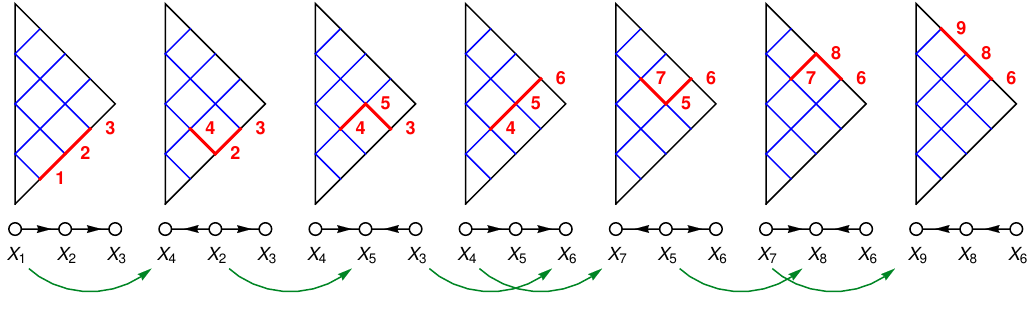
Figure 13 . Time evolution in (1 + 1) -dimensional spacetime and mutations on the